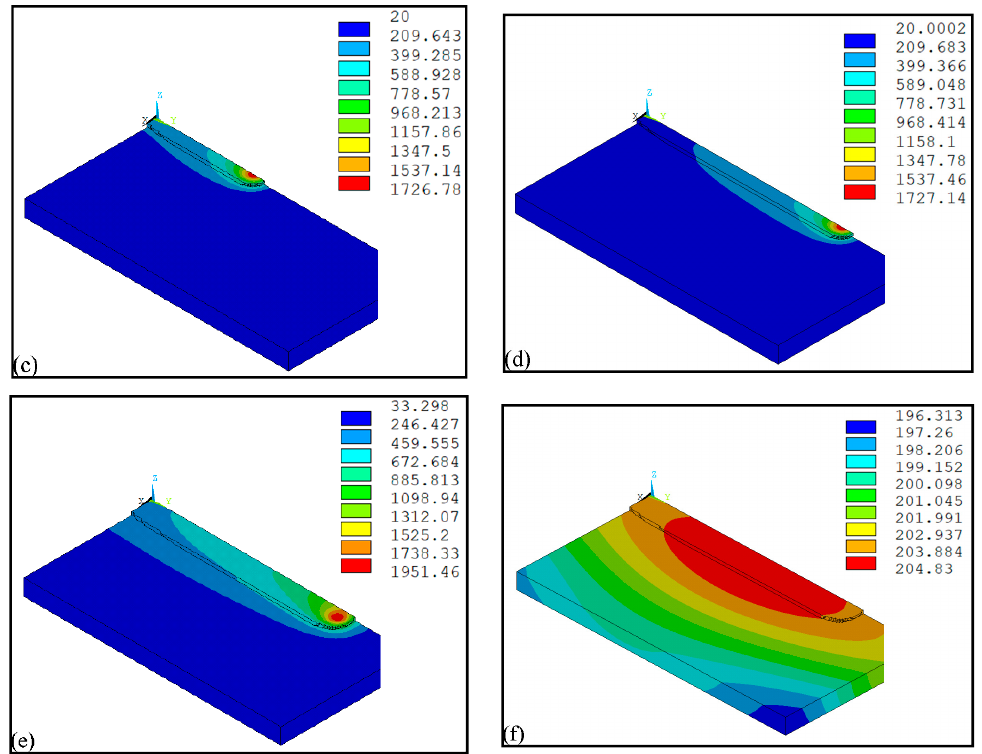
Figure 7. The temperature distribution of the laser overlapping process at a laser power of 1500 W and a scanning speed of 0.01 m/s: ( a ) 0 s; ( b ) 0.1 s; ( c ) 1.5 s; ( d ) 3 s; ( e ) 6 s; and ( f ) 56 s.